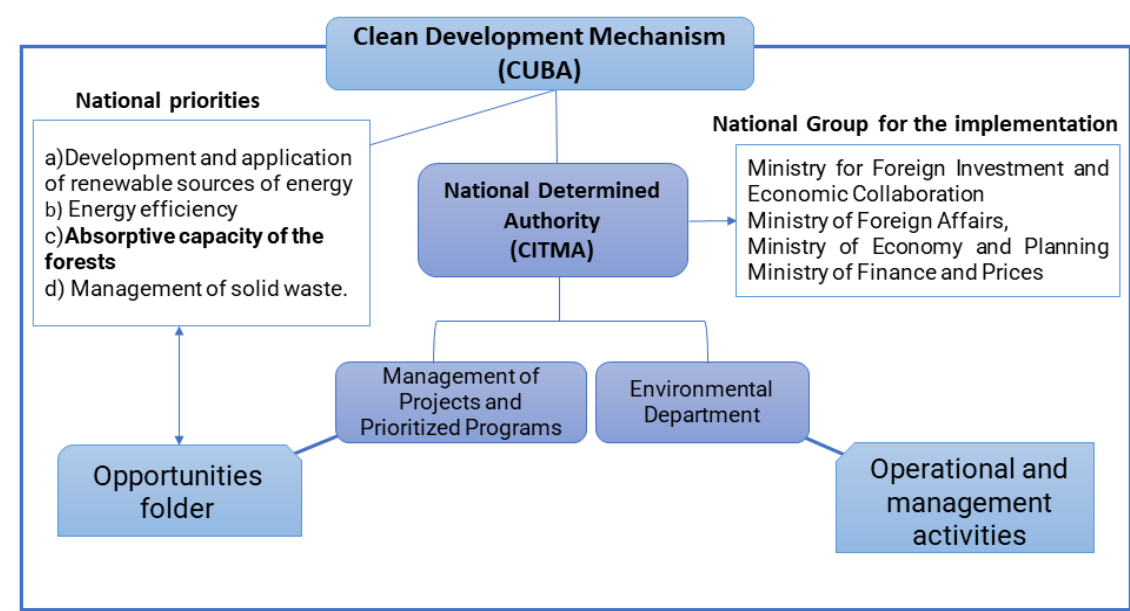
Figure 3. Scheme of competencies for the implementation of the CDM in Cuba according to Ministerial Resolution No. 76 of 2003 [60].